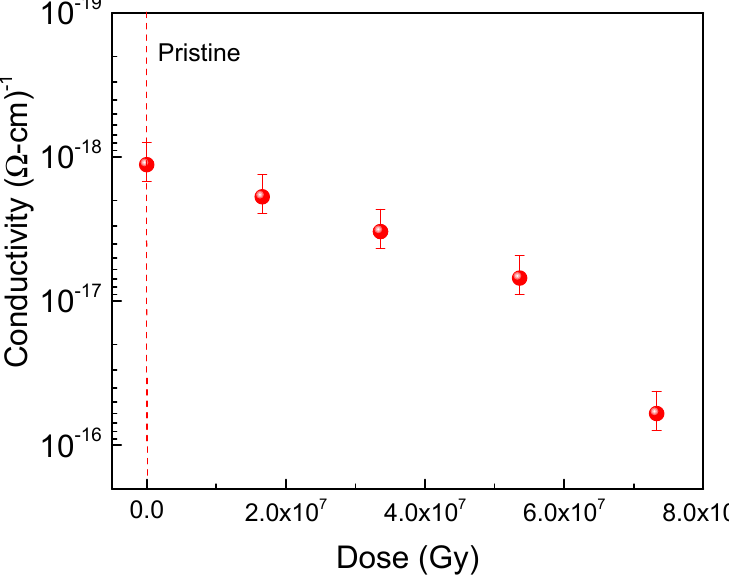
Figure 3. Conductivity of PI material irradiated with different doses.